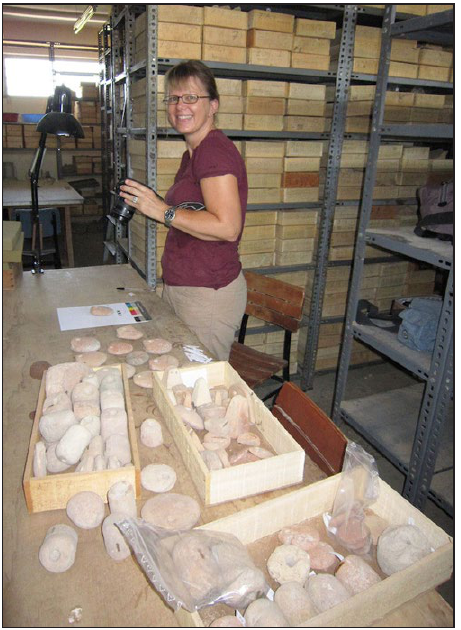
Figure 1: Jo Cutler in the storerooms at Miletus in Turkey in 2010 (Photo: Margarita